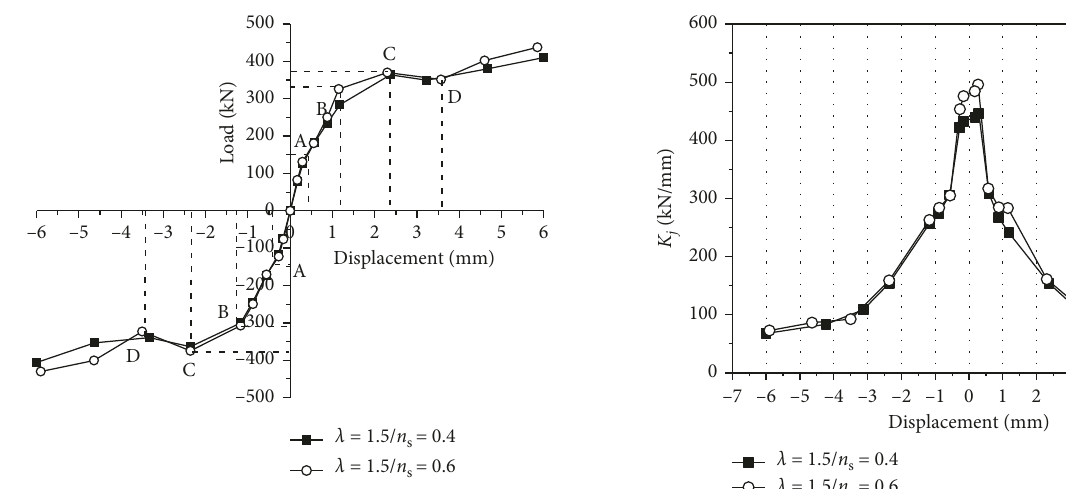
Figure 21: Skeleton curves of ISSCC columns under different axial compression ratios.